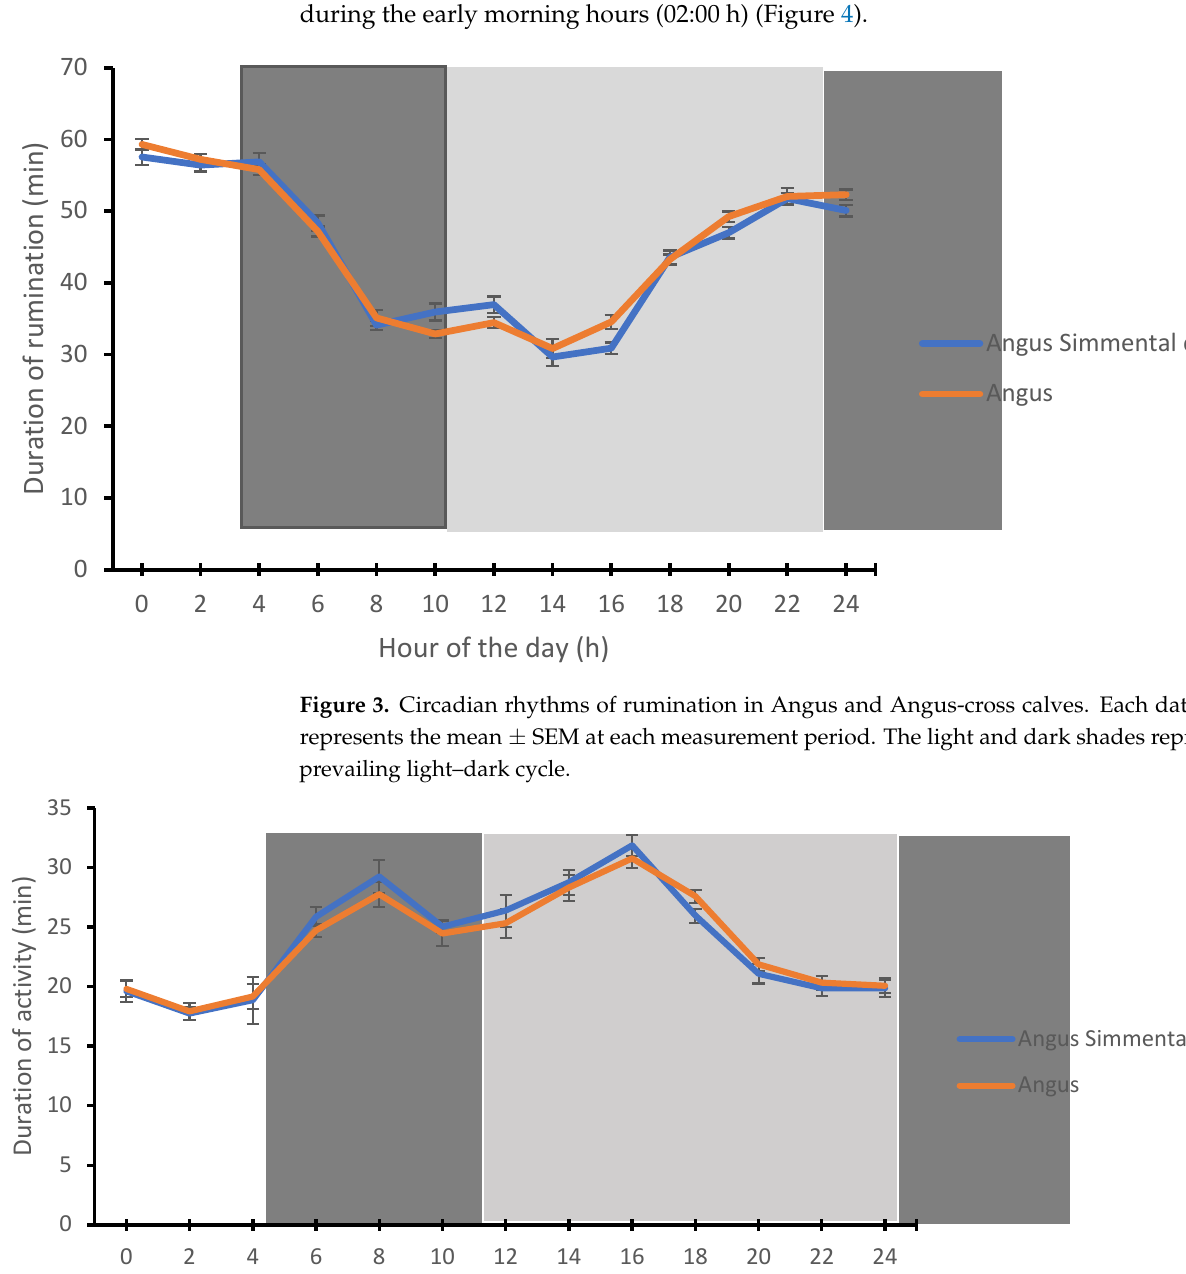
7 of 13 Figure 2. Circadian rhythms of activity behaviors in heifer and steer calves. Each datum point represents the mean ± SEM of the heifers and steers at each measurement period. The light and dark